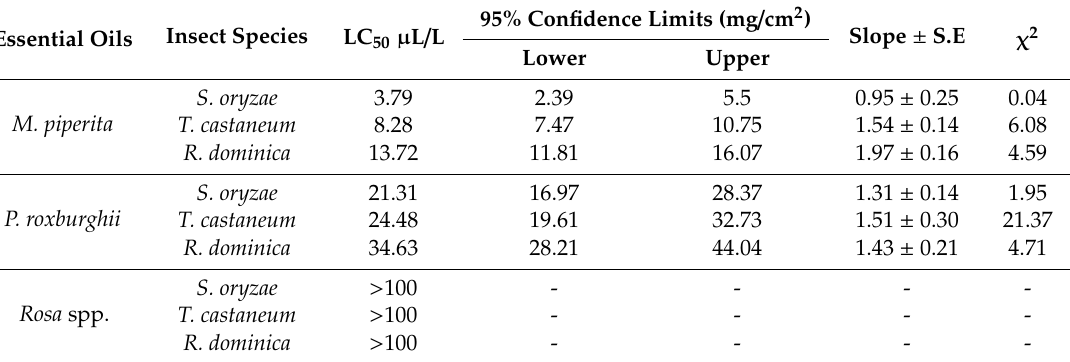
Table 6. Fumigant toxicity of the isolated essential oils against S. oryzae , T. castaneum , and R. dominica after 72 h.